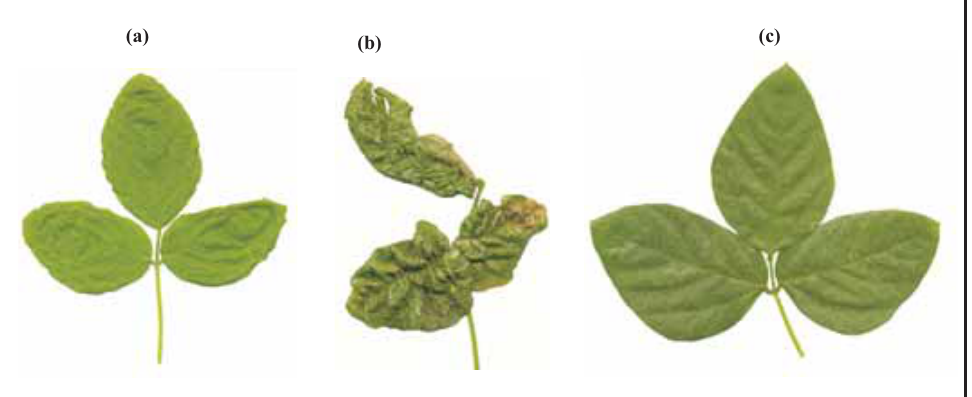
Figura 1. Sintomas de toxidez de Mn manifestada pelo cultivar IAC-15, a partir do oitavo dia após início do tratamento, considerando as doses de Mn de 200 μ mol L -1 (a), de 250 μ mol L -1 (b), em fase mais avançada, e de 2,0 μ mol L -1 (c), com trifólio sadio, sem